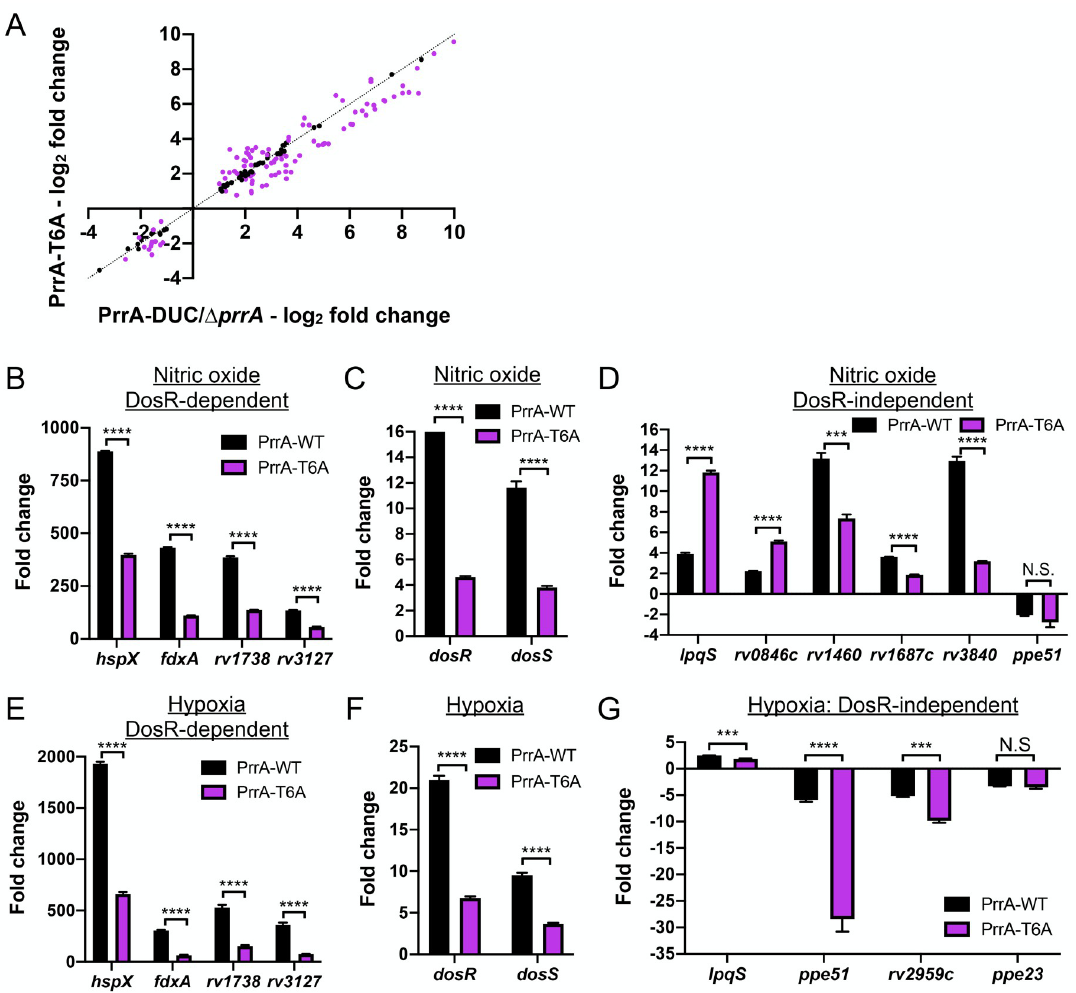
Fig 6. STPK phosphorylation of PrrA is critical for Mtb response to NO and hypoxia. (A-D) A STPK-phosphoablative PrrA variant strongly affects Mtb response to NO. PrrA-DUC/ Δ prrA and PrrA-T6A-DUC/ Δ prrA (“PrrA-T6A”) Mtb were grown in 7H9, pH 7.0 ± 100 μ M DETA NONOate for four hours. RNA was extracted for RNA sequencing analysis (A) or qRT-pCR (B-D). In (A), log 2 -fold change compares gene expression in the 7H9, pH 7.0 + 100 μ M DETA NONOate condition versus the 7H9, pH 7.0 control condition. Genes marked in purple had a log 2 -fold change difference � 0.25 between the PrrA-T6A-DUC/ Δ prrA and PrrA-DUC/ Δ prrA strains (p < 0.05, FDR < 0.01 in both sets, with log 2 -fold change � 1 in the PrrA-DUC/ Δ prrA set). In (B-D), fold change compares the 7H9, pH 7 + 100 μ M DETA NONOate condition versus the 7H9, pH 7 control condition. sigA was used as the control gene, and data are shown as means ± SD from 3 technical replicates. p-values were obtained with an unpaired t-test. N.S. not significant, ��� p < 0.001, ���� p < 0.0001. (E-G) The PrrA-T6A variant strain modulates Mtb response to hypoxia. qRT-PCR of PrrA-DUC/ Δ prrA (“PrrA-WT”) and PrrA-T6A-DUC/ Δ prrA (“PrrA-T6A”) were grown under aerated conditions before exposure to 1% oxygen for four hours. Fold change compares the 1% oxygen condition at 4 hours to the aerated 0 hour time point. sigA was used as the control gene, and data are shown as means ± SD from 3 technical replicates. p-values were obtained with an unpaired t-test. N.S. not significant, ��� p < 0.001, ���� p <